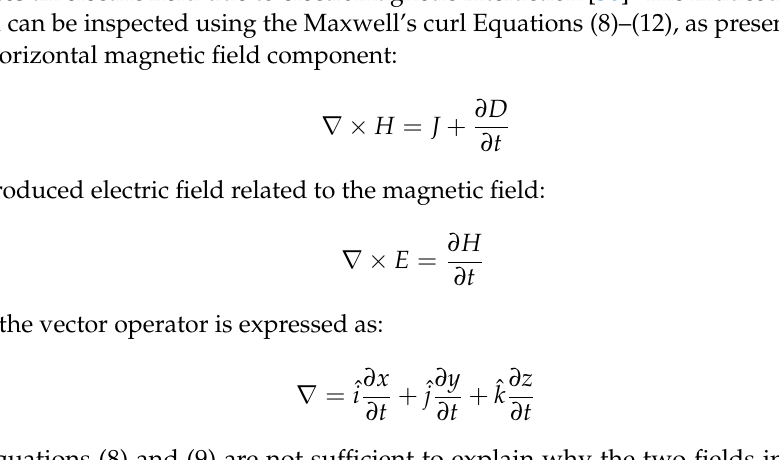
Horizontal magnetic field